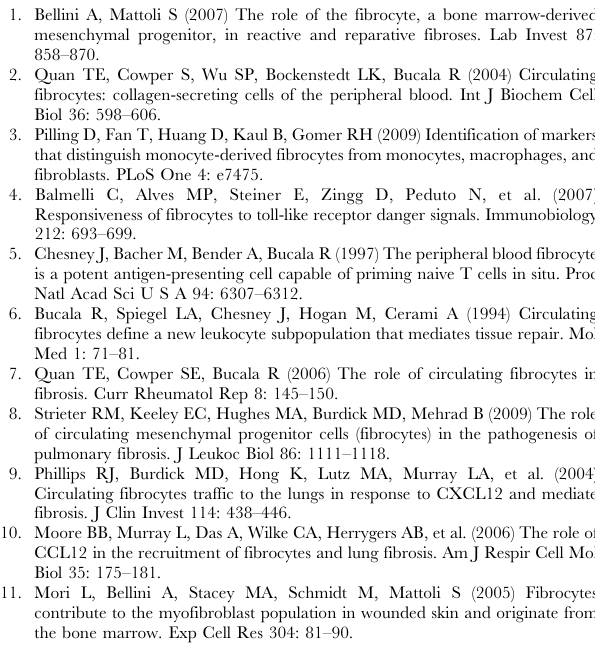
Fibrocytes were left untreated, or were transferred to medium containing fetal calf serum (FCS) or human serum (HS), with heat- inactivation as indicated (HI). B - the number of cells with fibrocyte morphology is shown (mean 6 sd of triplicate culture wells) over a number of days following a change of the culture medium as indicated; serum-free (SF), serum-containing (SC). Error bars are only shown in one direction for clarity. Figure S3 Serum-free fibrocytes retain expression of stromal and haematopoietic cell markers in the presence of serum. Fibrocytes were generated from PBMC under serum-free (SF) culture conditions and transferred to serum-containing conditions for 24 h before immunostaining for vimentin, fibronectin and CD45. Bar represents 50 m m. Data are representative of two separate experiments. The brightness and contrast of these images have been increased (20% and 25%, respectively). Table S1 Genes identified by SAM (0.1% FDR) when comparing monocytes, macrophages, osteoclasts, iDC, mDC, SC fibrocytes, SF fibrocytes and fibroblasts.